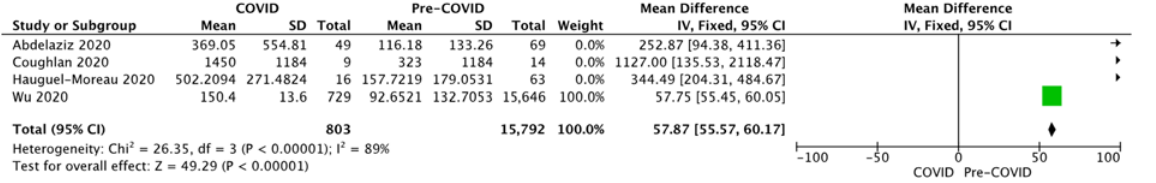
Figure 3. Forest plots for symptoms-to-FMC time.